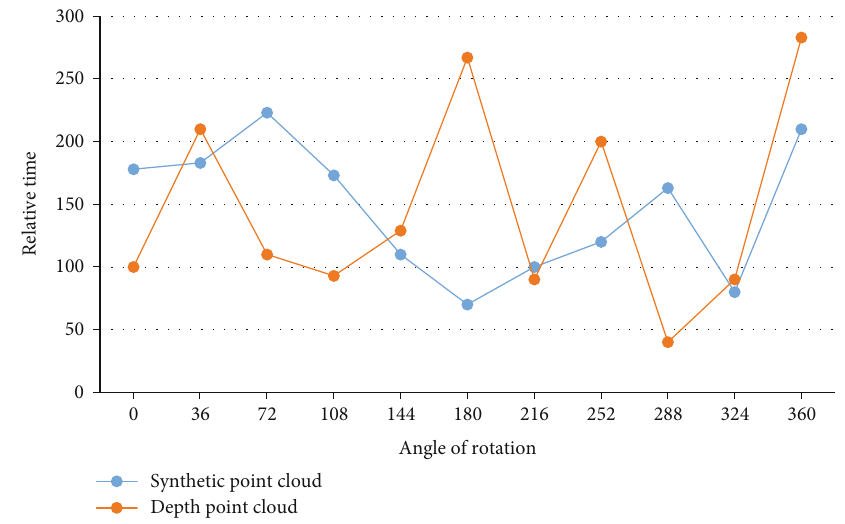
Figure 6: E ffi ciency comparison based on rotation angle.